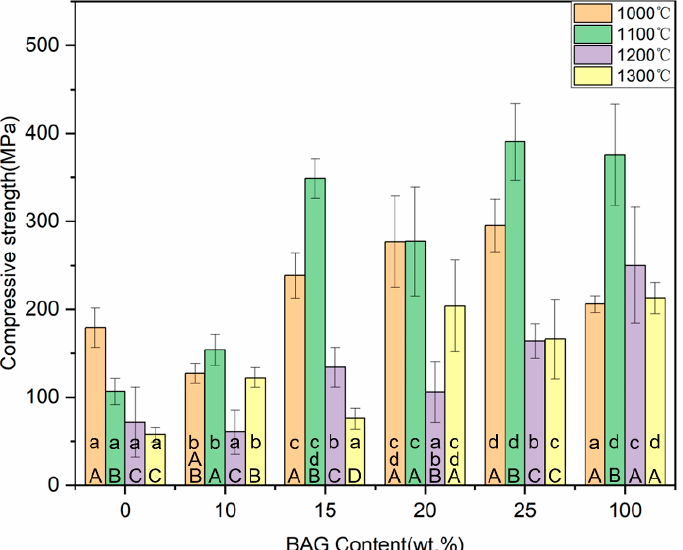
Figure 12. Flexural modulus of specimens with different sintering temperatures and different BAG contents. a the same lowercase letters indicate that there was no significant difference between different BAG contents at the same sintering temperature ( p = 0.05). A the same uppercase letters indicate that there was no significant difference between different sintering temperatures with the same BAG content ( p = 0.05). The data were significantly drawn from a normally distributed population at the 0.05 level.